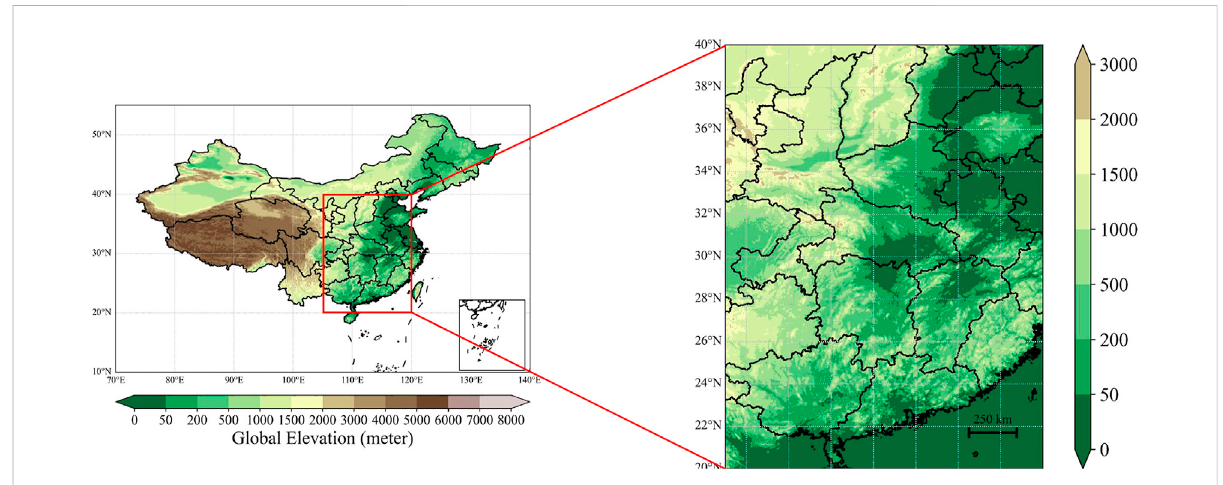
FIGURE 1 The study area. The colored bar represents the elevation of the